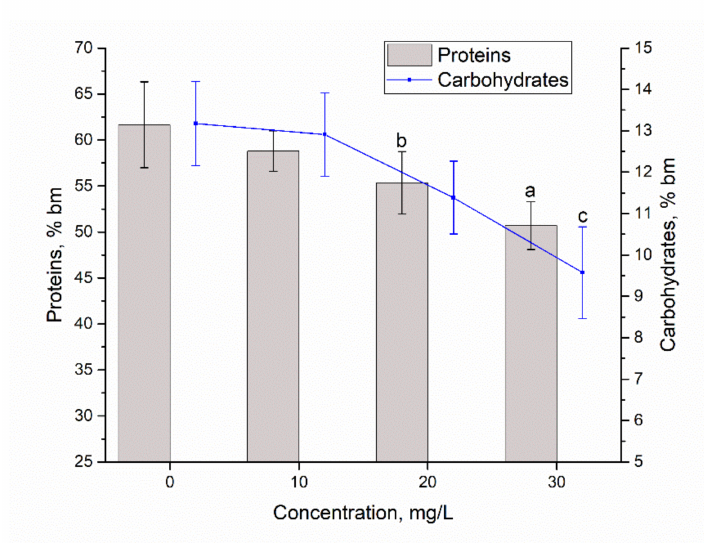
Figure 5. The content of protein and carbohydrates in A. platensis biomass exposed to Eu(III) in concentrations 10–30 mg/L (a— p < 0.01, b— p < 0.05, c— p < 0.005 for the difference between sample and